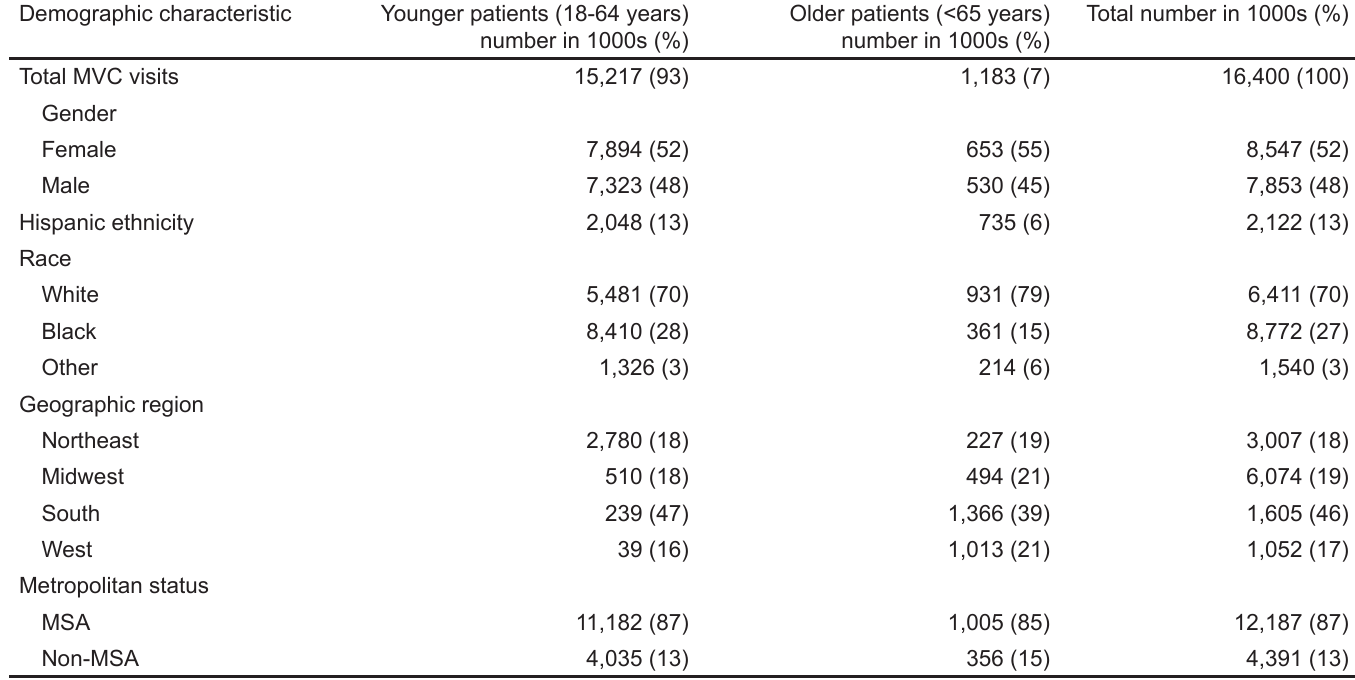
Table 1. Comparison of demographic and geographic characteristics of motor vehicle crash patients treated in emergency departments by age, United States 2003-2007.